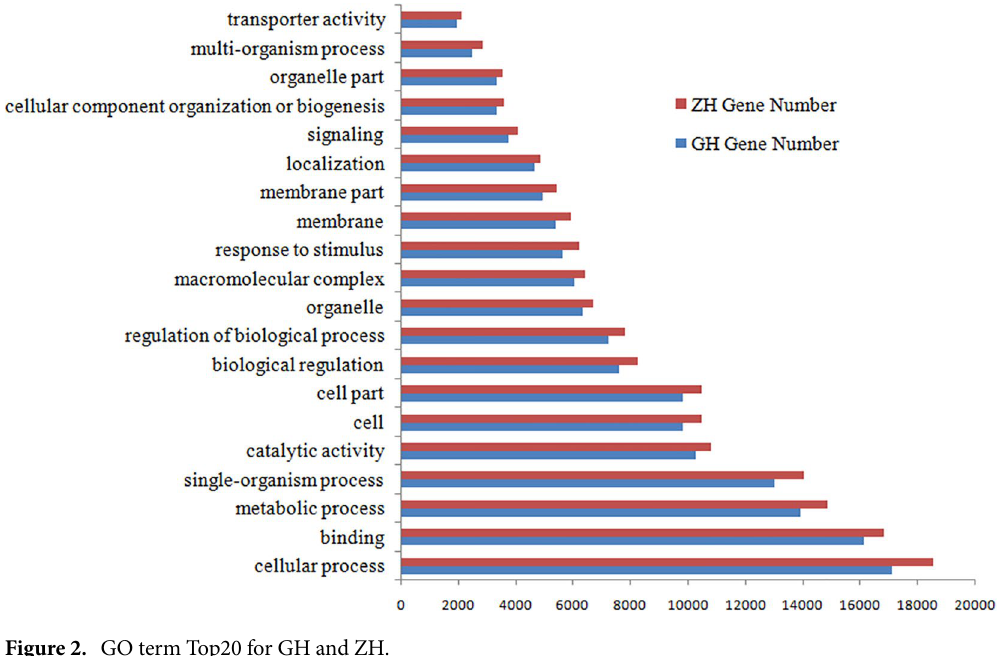
Figure 2. GO term Top20 for GH and